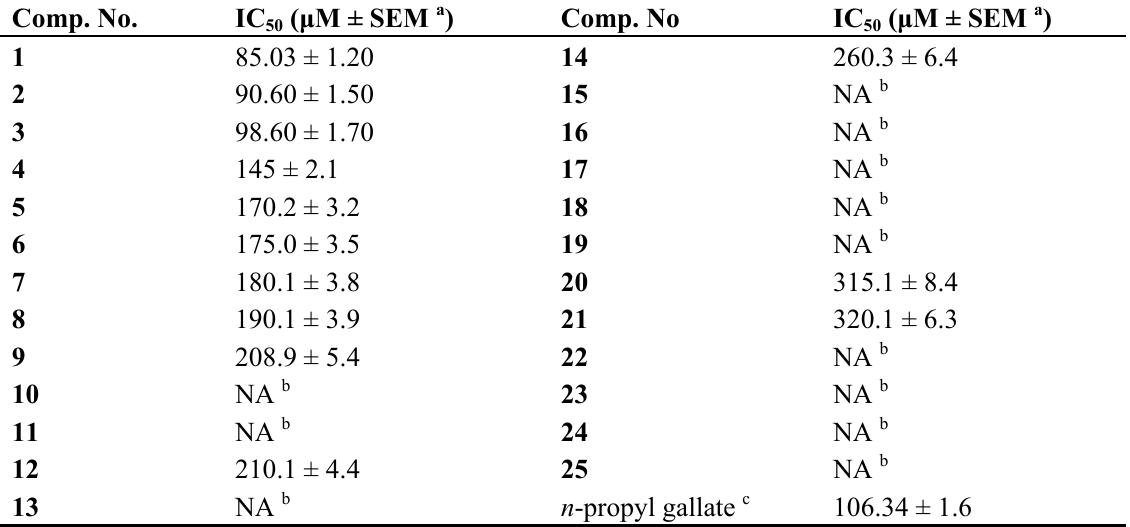
Table 2. In vitro superoxide anion radical scavenging activity of compounds 1 – 25 . Comp.